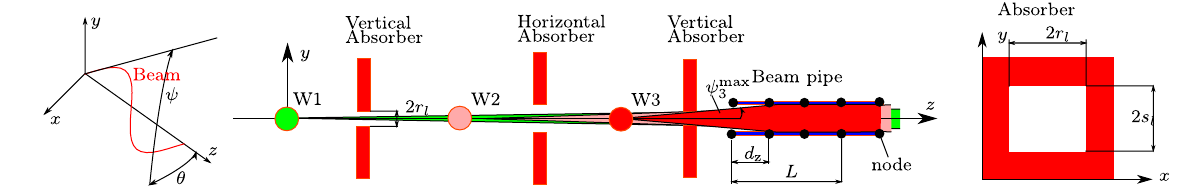
FIG. 11. Principle of synchrotron radiation emission (left), absorber scheme (middle), and absorber layout